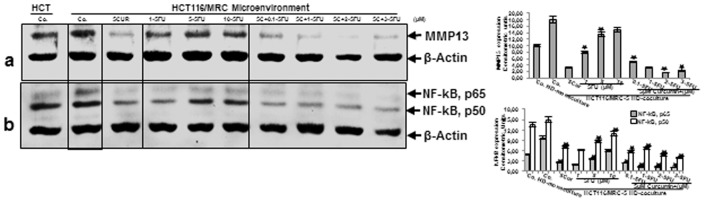
Effects of 5-FU, curcumin and the combinational treatment on proliferation-, metastatic gene products and NF-κB expression in the high density tumor microenvironment co-culture.HCT116 high density mono-cultures were either left untreated (HCT, Co.) or were co-cultured with MRC-5 in monolayer. Tumor microenvironment co-cultures were either left untreated (Co.), treated with curcumin alone (5µM), 5-FU alone (1, 5, and 10µM) or were pretreated for 4 h with curcumin (5µM) followed by treatment with 5-FU (0.1, 1, 2, 3µM). After 10 days of culture, total cell lysates of HCT116 high density cultures were prepared and analyzed by western blotting and quantitative densitometry for MMP-13 (a) and NF-κB (b). Densitometric evaluation of protein expression as revealed by western blot analysis was performed in triplicate. Housekeeping protein β-actin served as a loading control in all experiments. Values were compared to the control and statistically significant values with p<0.05. Significant values are marked with (*).